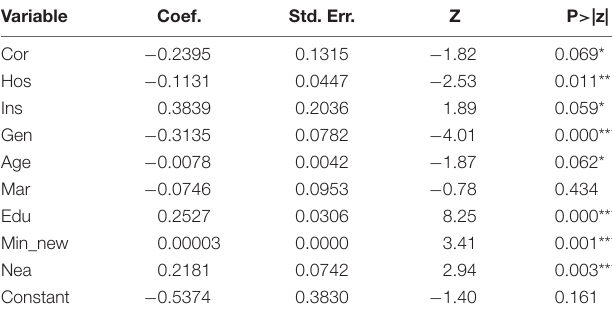
TABLE 5 | Results for robustness test with an alternative